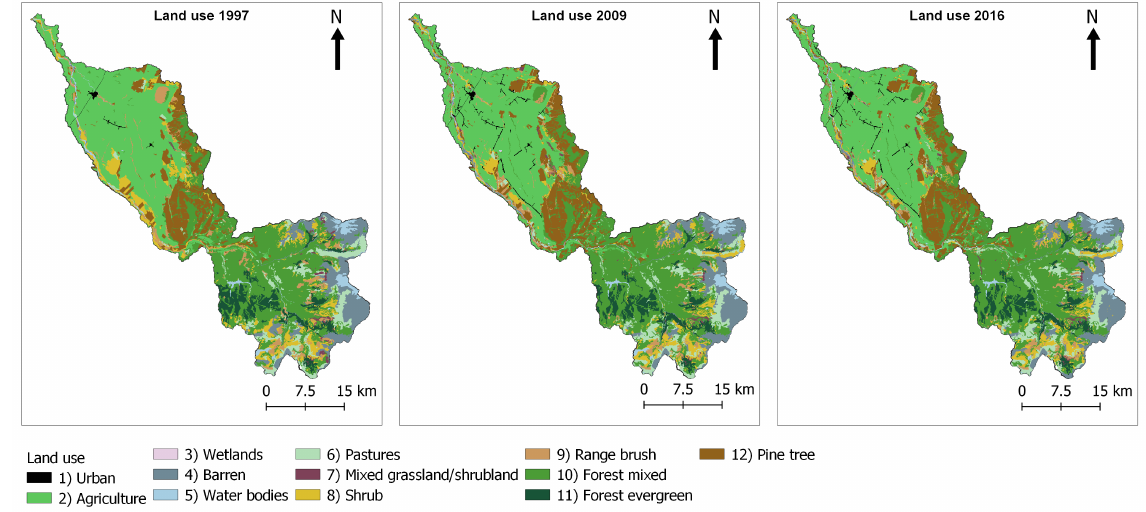
Figure 3. Land use maps of 1997, 2009, and